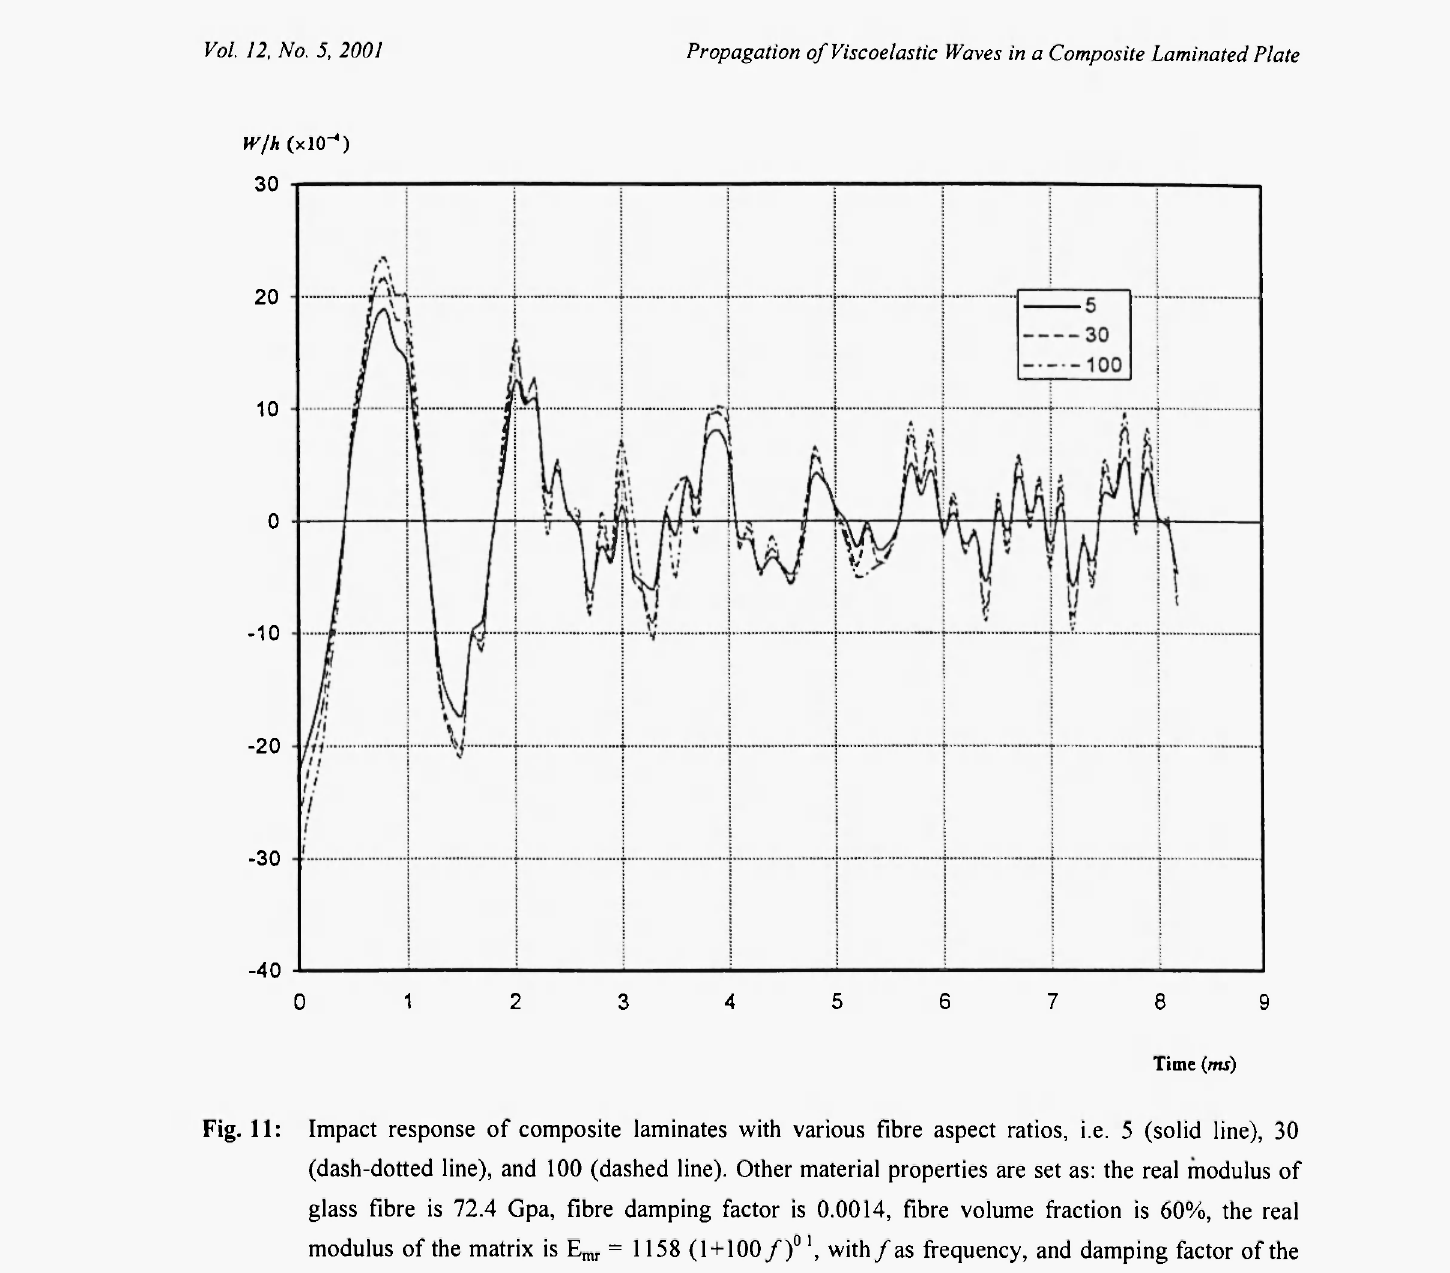
Fig. 11: Impact response of composite laminates with various fibre aspect ratios, i.e. 5 (solid line), 30 (dash-dotted line), and 100 (dashed line). Other material properties are set as: the real modulus of glass fibre is 72.4 Gpa, fibre damping factor is 0.0014, fibre volume fraction is 60%, the real modulus of the matrix is E^ = 1158 (1 + 100/)°', with / as frequency, and damping factor of the matrix is